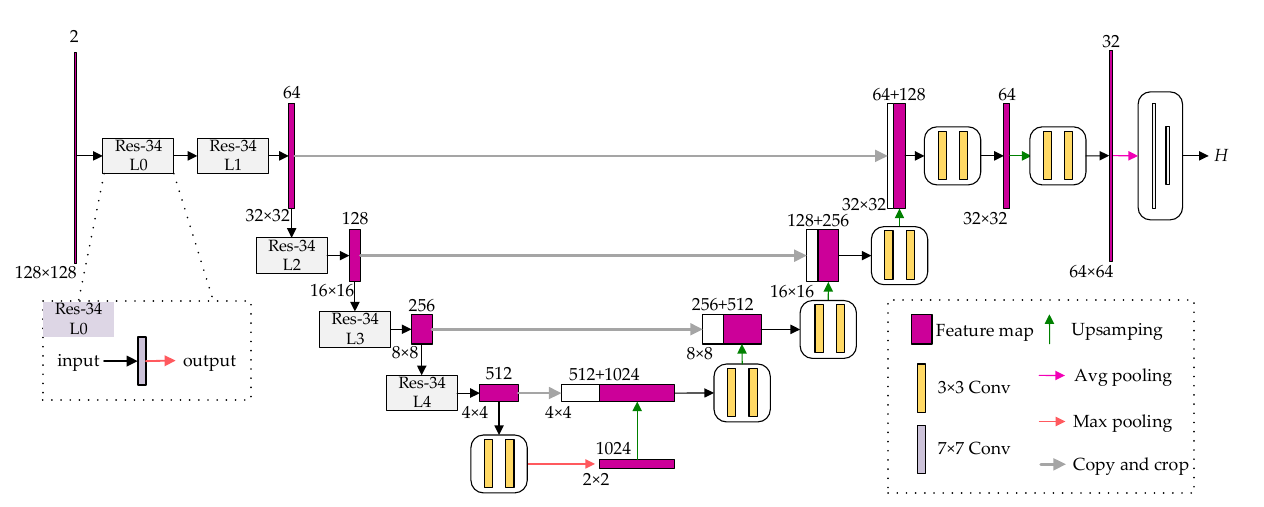
Figure 3. The network architecture of the generator. The network architecture of the generator is similar to the Unet [38] network, which is an encoder-decoder structure. The number in the lower left corner of the feature map in the figure represents the size of the feature map. The number above the feature map represents the number of channels on the feature map. It is worth noting that each Conv in the figure is followed by a batch normalization [37] and ReLu.